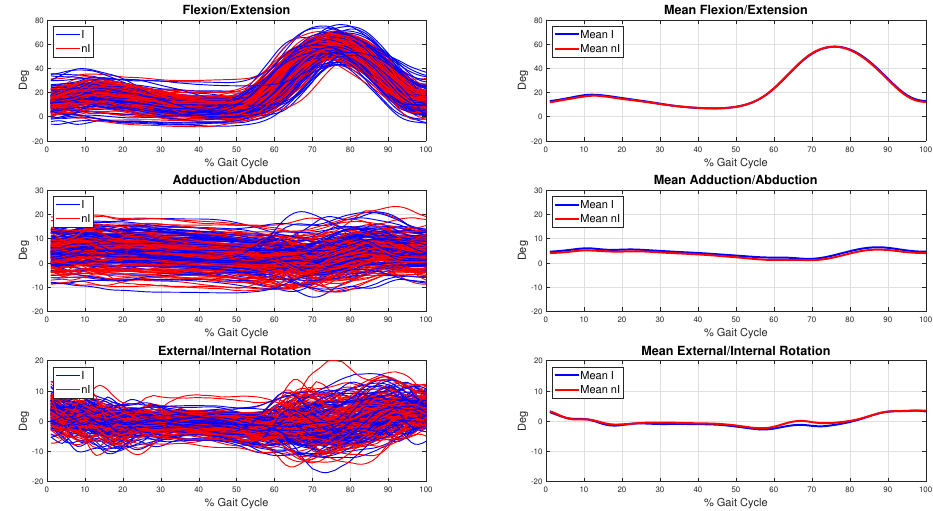
Figure 3. Kinematic curves of the 221 subjects (I: improved (blue) and nI: not-improved (red)). Angles are expressed in degrees: Flexion(+)/Extension( − ), Adduction(+)/Abduction( − ), External(+)/Internal( − )